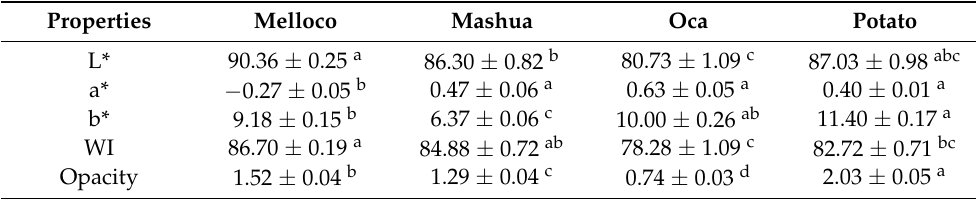
Table 1. L*, a*, and b* color parameters, whiteness index (WI) and opacity data measured on films yielded from each Andean tuber